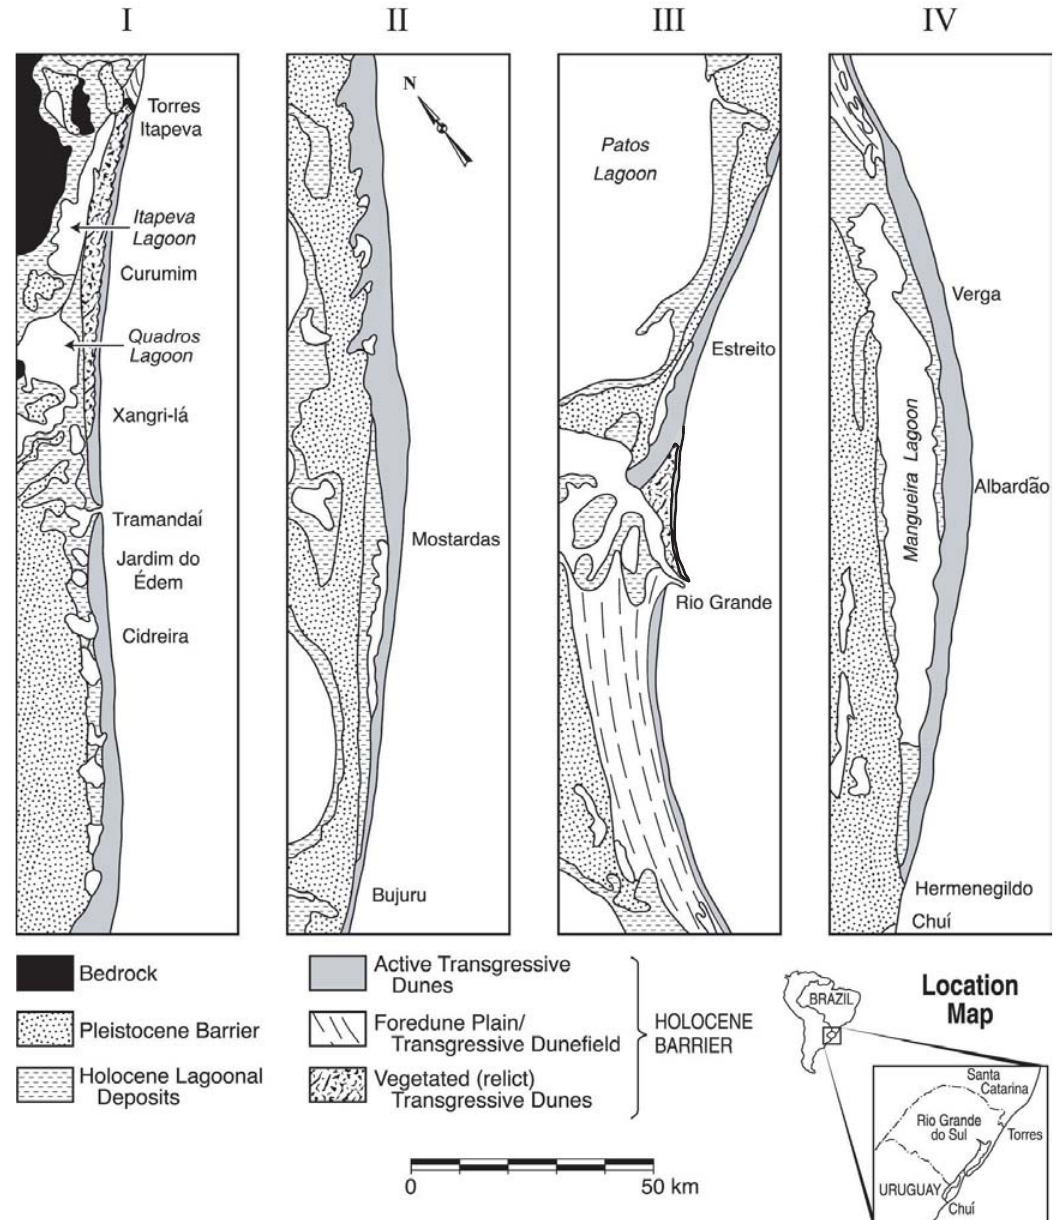
Fig. 1 – Pleistocene and Holocene barriers along the southern Brazilian coast from Torres to Chui. The first map (I) displays the northernmost sector and II, III, and IV the progressively more southern sectors. Barrier types are indicated for the Holocene barrier. This re-interpretation of the Dillenburg et al. (2000) figure indicates that the barrier system comprises relict (vegetated) transgressive dunefields, active transgressive dunefields, or a complex barrier type comprising both foredune ridges and transgressive